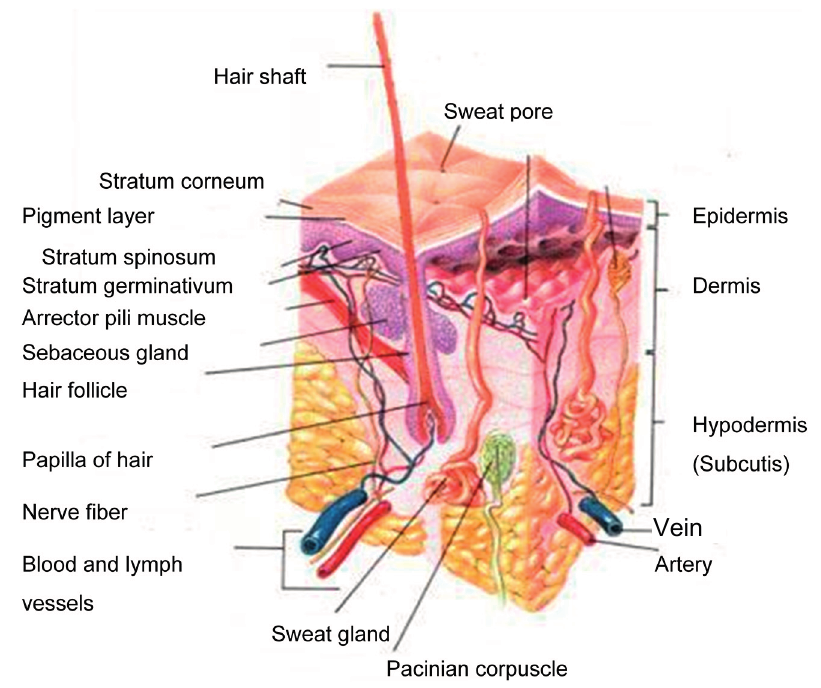
Figure 1. A schematic cross-section of human skin